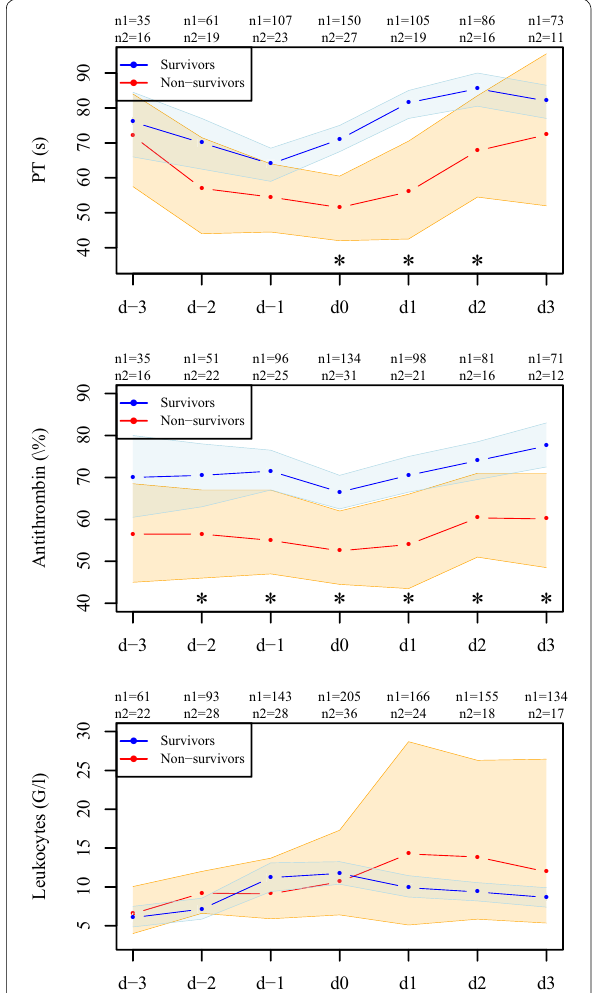
Fig. 2 Progression of measured coagulation parameters. Depicted are medians with 95% CIs of the measured parameters for survivors (blue) and non-survivors (red) from 3 days prior to (d-3 to d-1) until 3 days after (d1 to d3) C-reactive protein peaked (d0). Asterisks indicate significant differences between survivors and non-survivors at the respective time point; n 1 is the number of available measurements for survivors and n 2 for